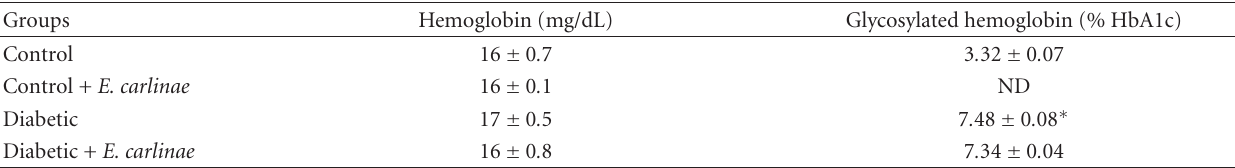
Table 2: E ff ect of E. carlinae on hemoglobin and glycosylated hemoglobin